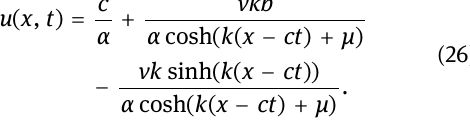
Example 5. Considered initial and boundary conditions are as per [ 12,52,53 ] .